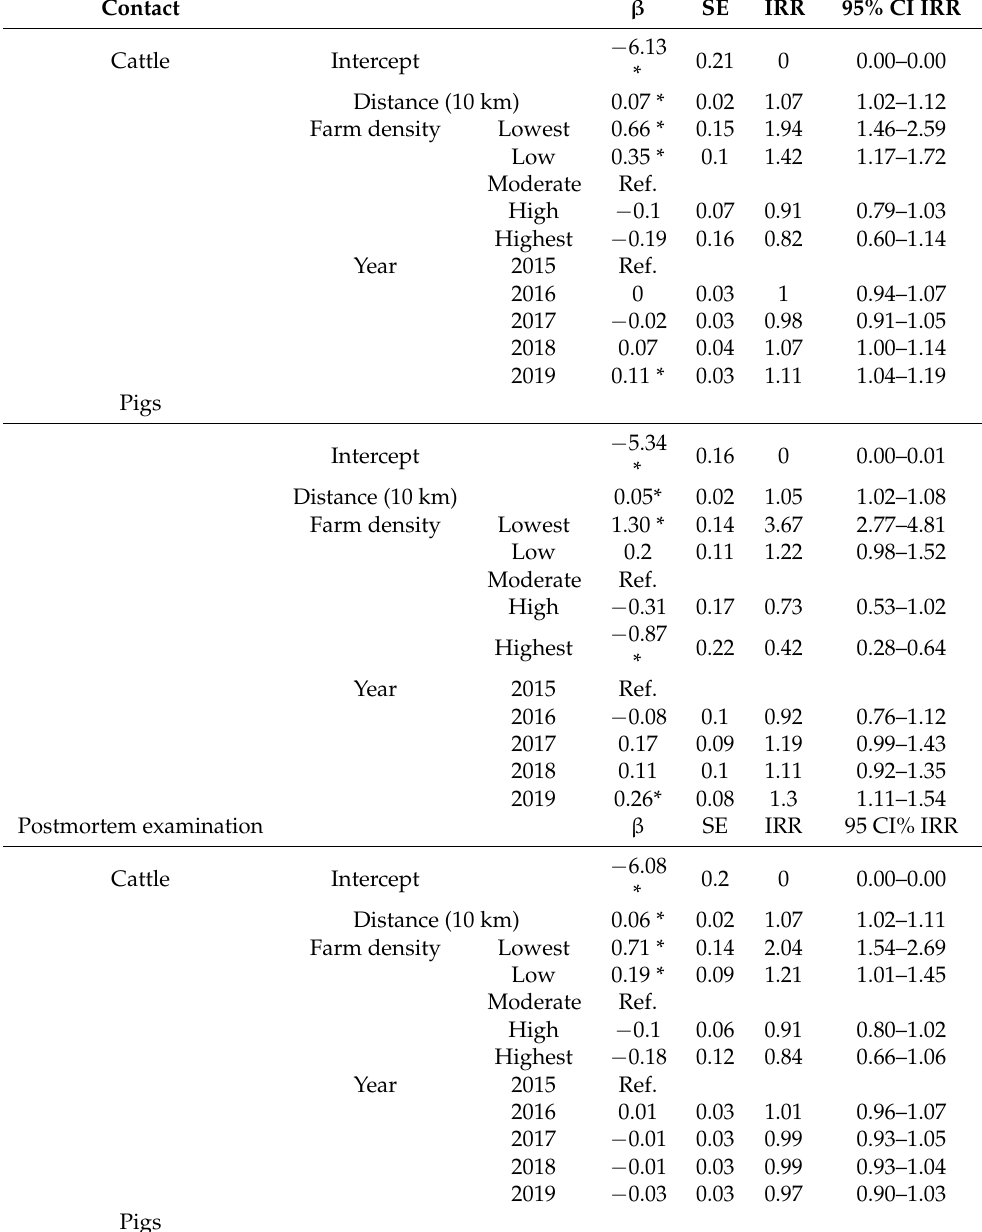
Table 7. Association of distance to GD facility and farm density with helpdesk contact and post- mortem examination from 2015 and 2019 in the